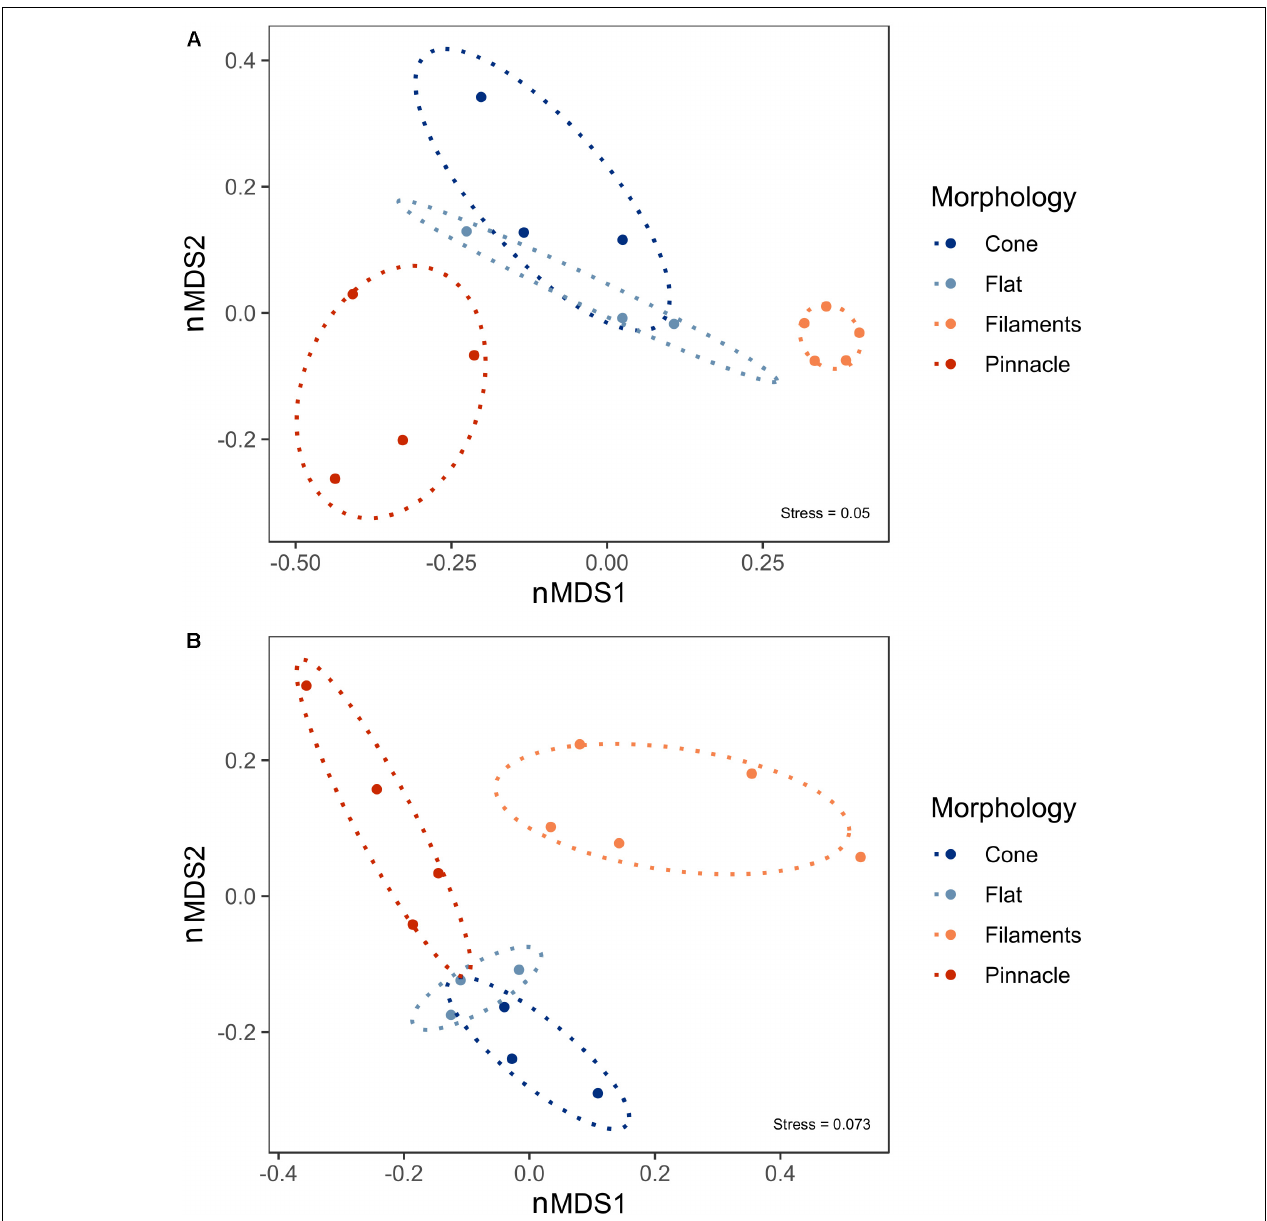
FIGURE 6 | Non-metric Multidimensional scaling (nMDS) plot derived from standardized ASV abundance for (A) prokaryote and (B) eukaryote communities in 15 benthic microbial mat samples from Lake Untersee. Ellipses represent 95% confidence intervals.